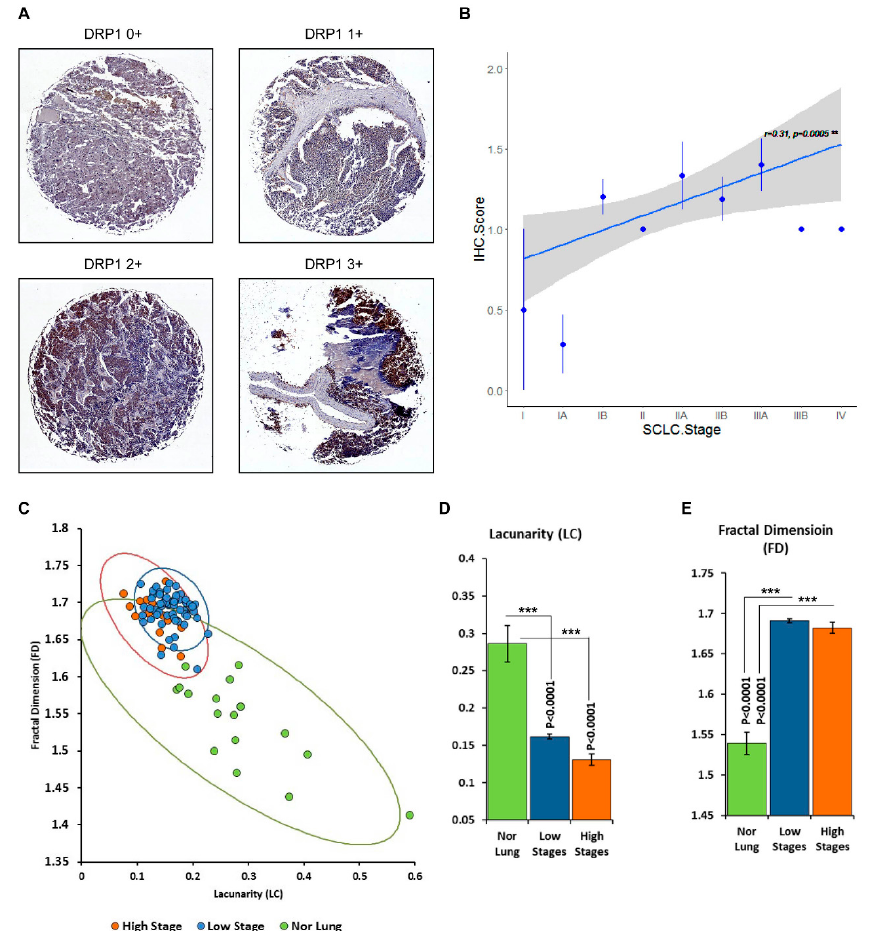
Figure 1. Upregulation of dynamin 1 like protein (DRP1) in human small cell carcinomas. ( A ) Representative images of immunohistochemical staining of DRP1 in tissue microarray (TMA) sections. Detailed procedures are described in the materials and methods. DRP1 immunostaining was moderated (1 + / 2 + ) in 69 tumors and score 3 + was observed in one tumor stage III disease. ( B ) Correlation analysis confirmed a significant positive correlation between the DRP1 score and stage of tumor ( r (78) = 0.31, p = 0.005) using R (v3.2.3) for quantitate analysis. The blue dots are the average IHC score at each cancer stage and the blue bar is the standard error. The blue line is the regression line and the gray area is the 95% confidence interval. The diagram was generated using R’s ggplot2 library. ( C ) Normal lung tissue and small-cell carcinoma were scanned and the images were then converted to 8-bit greyscale using ImageJ 25 . The box-counting FD ( D B ) and lacunarity ( Λ ) of specimens of normal lung tissue ( n = 18) and histological variants of SCLC tumors ( n = 79) were calculated using FracLac [18]. Tumors were separated to low-stage ( n = 65) and high-stage groups ( n = 14). The low-stage group includes stage I, II, IIA, and IIB samples. The high-stage group includes IIIA, IIIB, and IV samples. Scatter plot of lacunarity vs. fractal dimension with confidence ellipses per tissue type (95% confidence interval). ( D and E ) Graphical representation of mean values of LC and FD in TMA sections of lung normal and tumor tissues. Error bars = standard error. p- values indicate significance from one-way variance analysis (ANOVA). *** p <